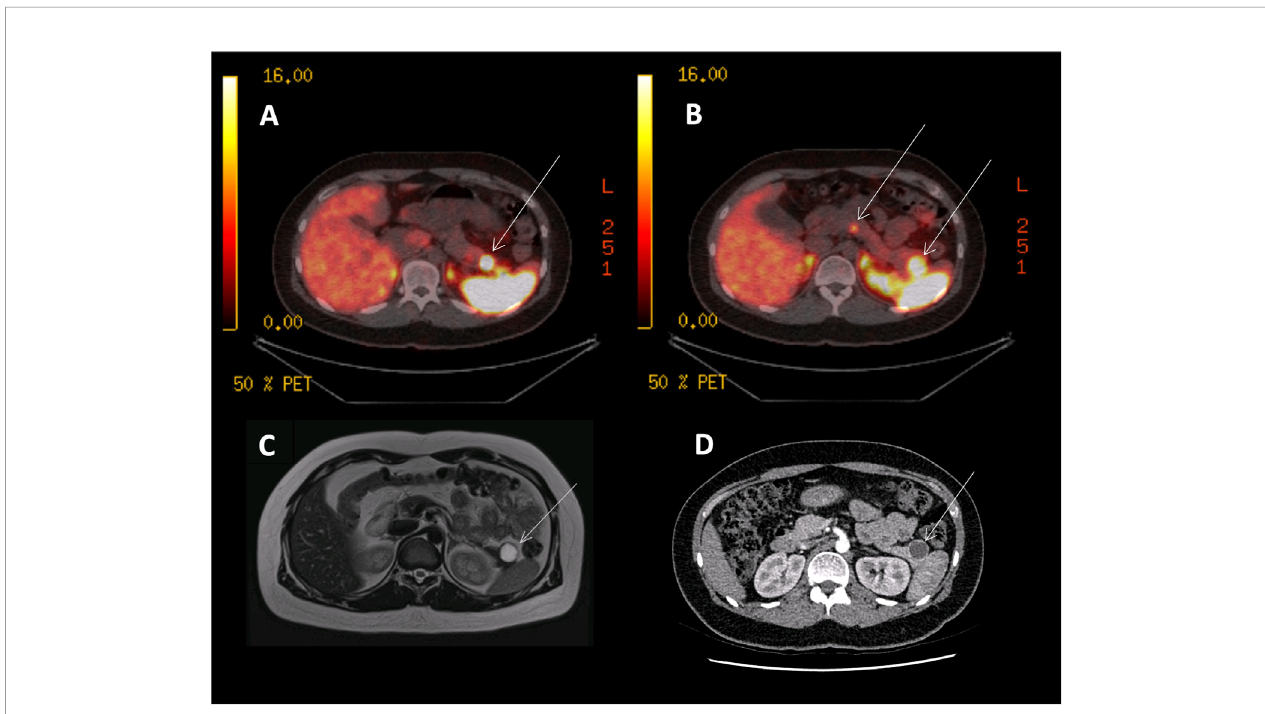
FIGURE 1 | 68 Ga-DOTANOC PET, CT and MRI images of an MEN1 patient with three panNETs (T3N0M0). (A) 68 Ga-DOTANOC PET/CT image showing a single panNET uptaking tracer in the pancreatic tail. (B) 68 Ga-DOTANOC PET/CT image showing two additional PanNETs in the tail and neck of the pancreas. (C) MRI scan showing a single lesion in the tail of the pancreas, commented as being ‘ cystic ’ and needing further imaging and discussion at MDT. (D) A CT scan showing a single cystic lesion in the tail of the pancreas, commented on as likely being a